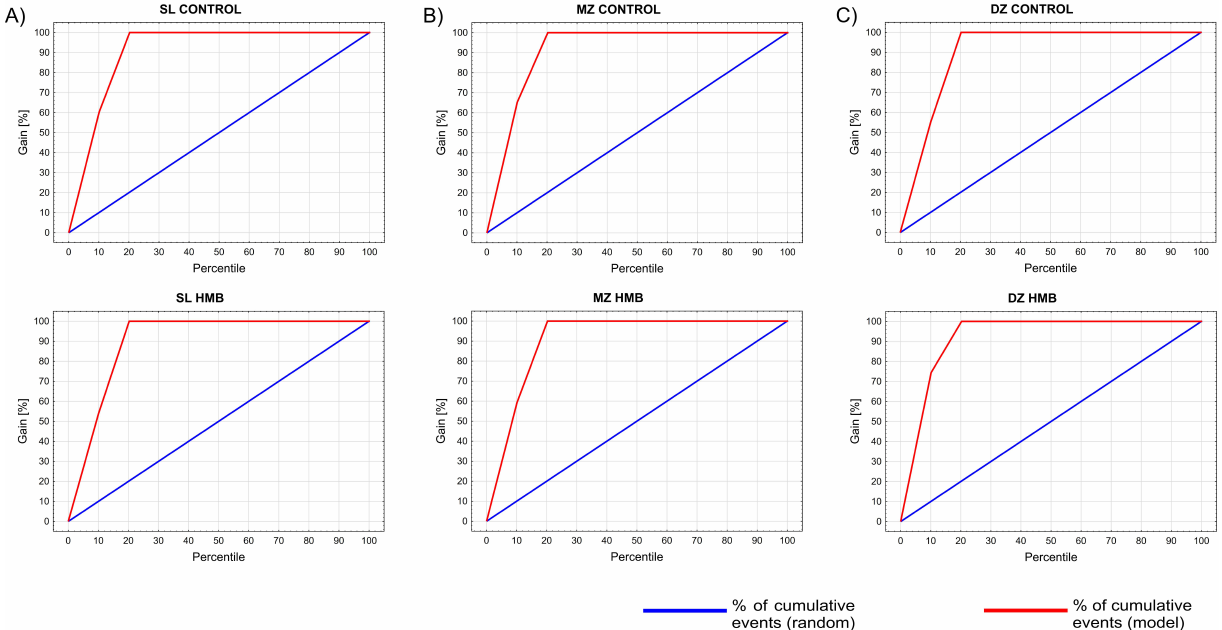
Figure 5. Gain charts constructed for the examined groups showing the effectiveness of a classification model calculated as the ratio between the results obtained with (red line) and without (blue line) the model. HMB—supplemented group, SZ—superficial zone, MZ—middle zone, DZ—deep zone. Table 4. Results of the training process of SOM network with 25 output